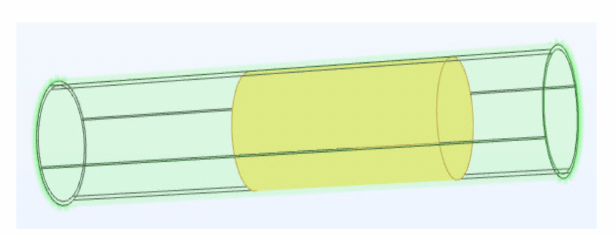
Figure 5. Calculation model of energy capture